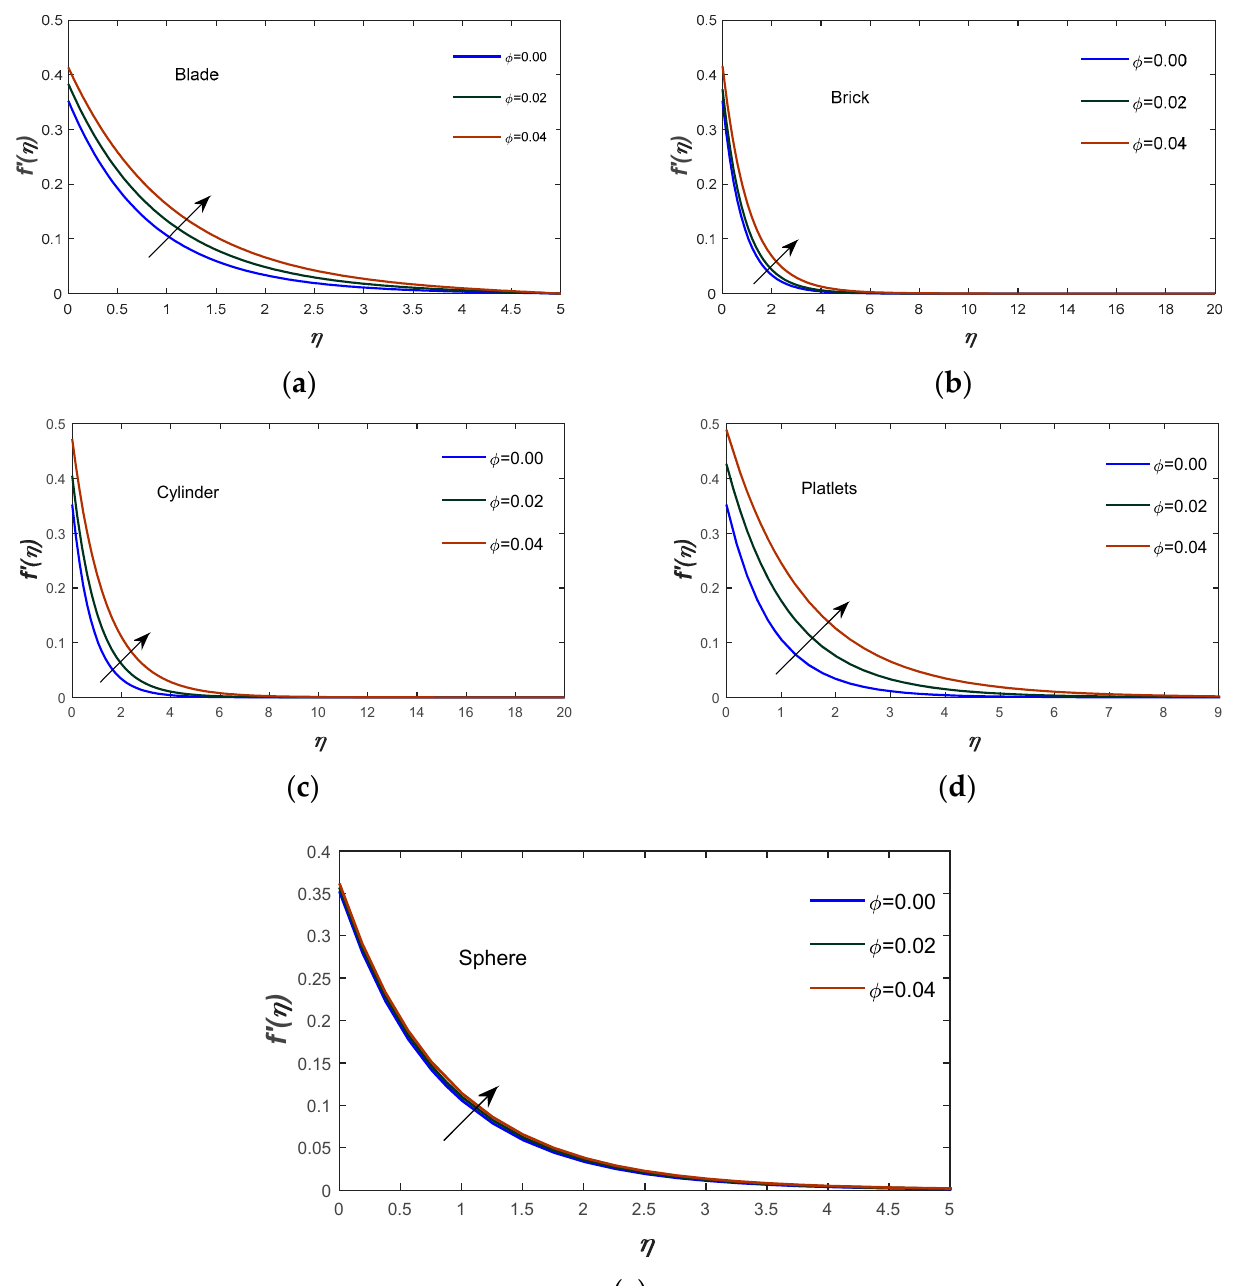
Figure 5. ( a – e ). Impact of 𝜑 on 𝑓′(𝜂) by using various shapes factors of nanoparticles for fixed 𝑀 = 1.0, 𝑃𝑟 = 6.0, 𝑘 = 0.5, 𝐸𝑐 = 1.0, 𝑆 = 0.5 .